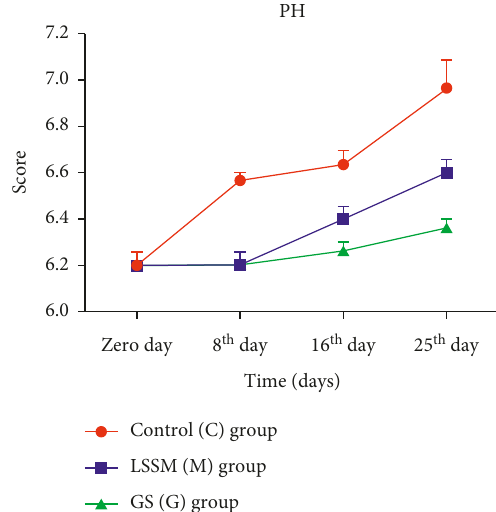
Figure 4: The means of pH values of treated catfish fillets with Lepidium sativum mucilage (LSSM) and LSSM-mediated Se NPs during storage at refrigeration